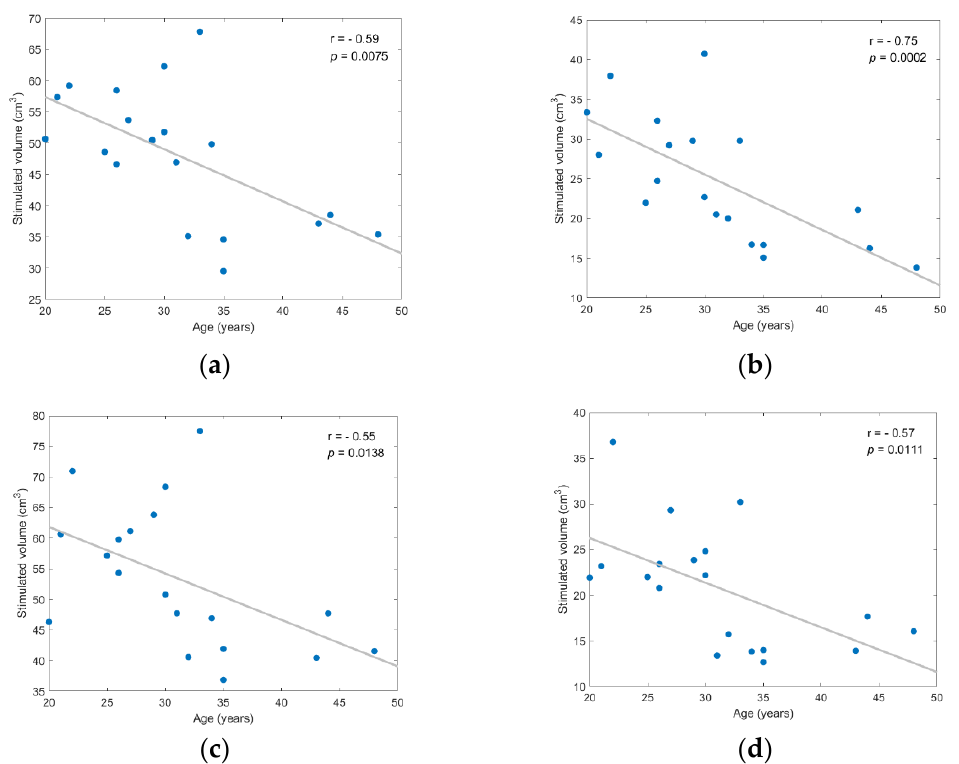
Figure 7. Stimulated volume showed statistically significant negative correlation to age for each investigated scenario; ( a ) frontal coil position on anatomical models; ( b ) frontal coil position on homogeneous models; ( c ) central coil position on anatomical models; ( d ) central coil position on homogeneous models.